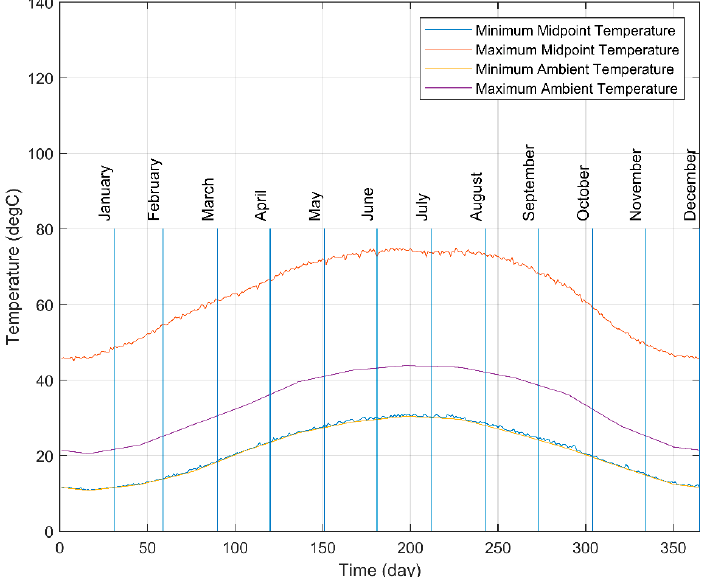
Figure 17. Maximum and minimum daily midpoint temperature and ambient temperature variation throughout 2022G.